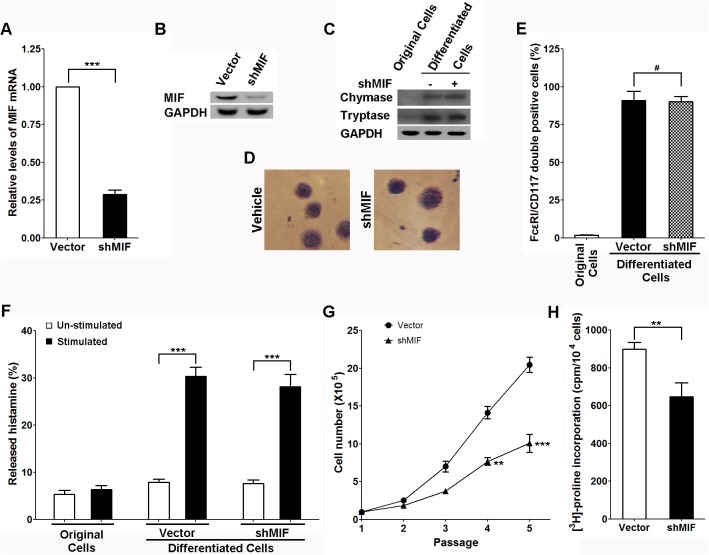
MIF knockdown inhibits the profibrogenic activity of Mast cells.A and B. The mRNA and protein levels of MIF in mast cells derived from CD34+ hematopoietic precursors with or without MIF knockdown. C. Western-blots of chymase, tryptase and GAPDH in original or mast cells (derived from CD34+ hematopoietic precursors with or without MIF knockdown). D. Toluidine blue staining of the mast cells derived from CD34+ hematopoietic precursors with or without MIF knockdown. E. Quantification analysis of FcεRI/CD117 double positive population in original or mast cells (derived from CD34+ hematopoietic precursors with or without MIF knockdown), #P>0.05. F. Histamine release assay of the mast cells derived from CD34+ hematopoietic precursors with or without MIF knockdown. G and H. The growth curves and collagen synthesis of fibroblast cultured in medium conditioned by mast cells with or without MIF knockdown, mean±SD, n = 3.